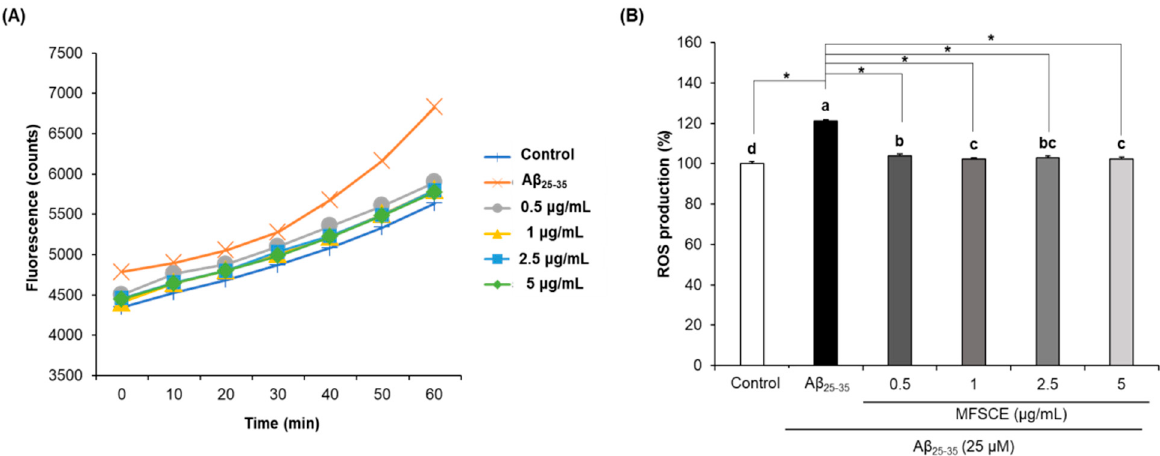
Figure 3. Effect of membrane-free stem cell extract (MFSCE) on production of reactive oxygen species in SH-SY5Y cells treated with A β 25–35 . ( A ) Changes in intensity of ROS fluorescence during 60 min. ( B ) The production of ROS in cells treated with different concentrations of MFSCE at 60 min. Values are presented as mean ± SD ( n = 6). The different letters (a–d) among groups represent significant differences determined by ANOVA and Duncan’s multiple range test (p < 0.05). * p < 0.05 vs. A β 25-35 -treated cells.